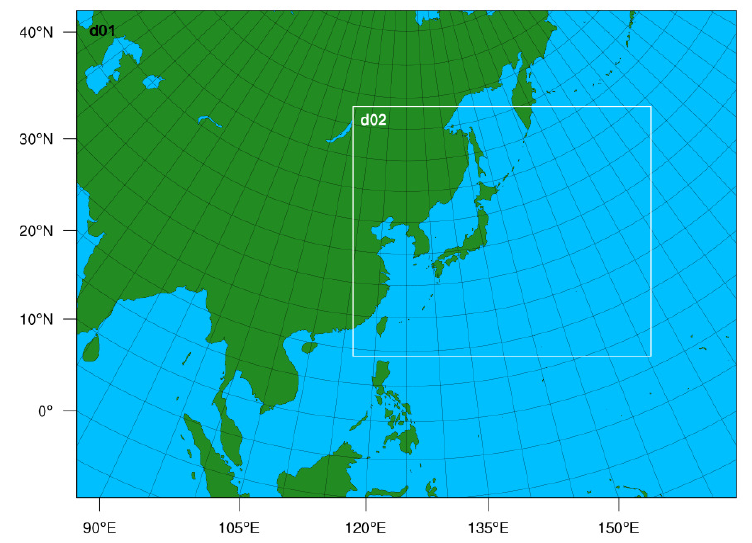
Figure 6. Domains for WRF